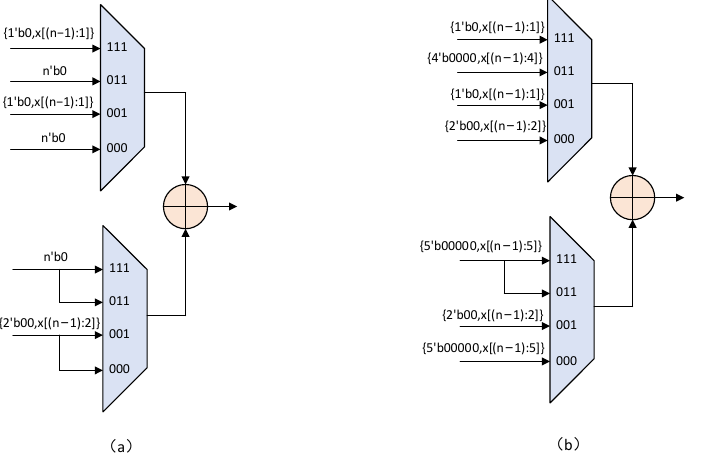
Figure 1. SAA parts of ML ‐ PLAC ( a ) and OML ‐ PLAC ( b ).